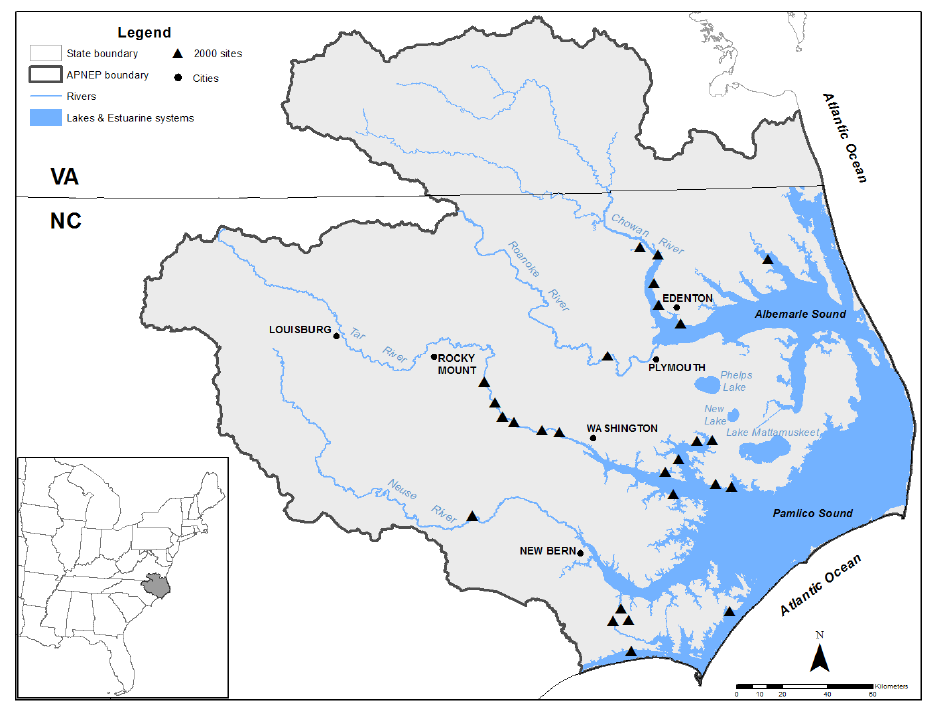
Figure 1. Map of the 26 sites in the Albemarle-Pamlico Estuarine System where surface water samples were collected in 2000 for herbicide analysis.